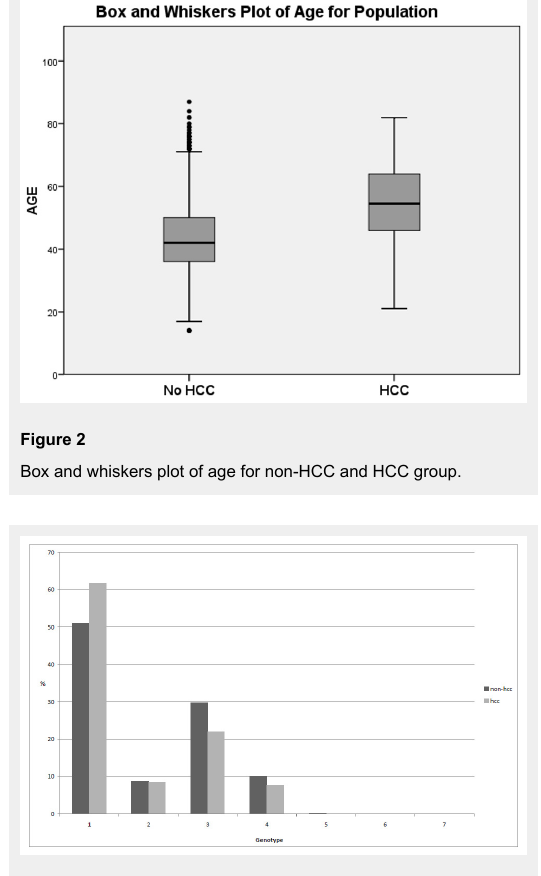
Figure 3 Frequency hepatitis C virus genotypes, compared between HCC and non-HCC